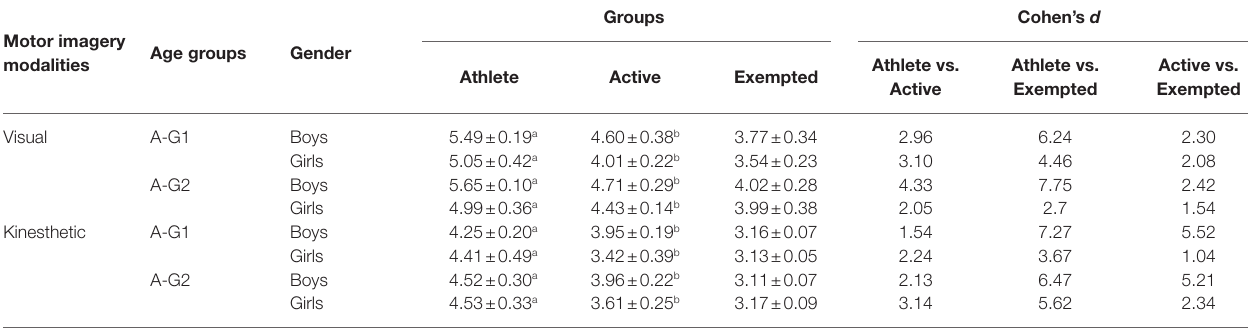
TABLE 4 | Groups effect on motor imagery vividness (comparison of groups 2 by 2).